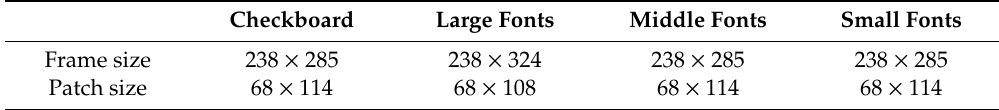
Table 1. The Frame Size and Patch Size of Di ff erent Data